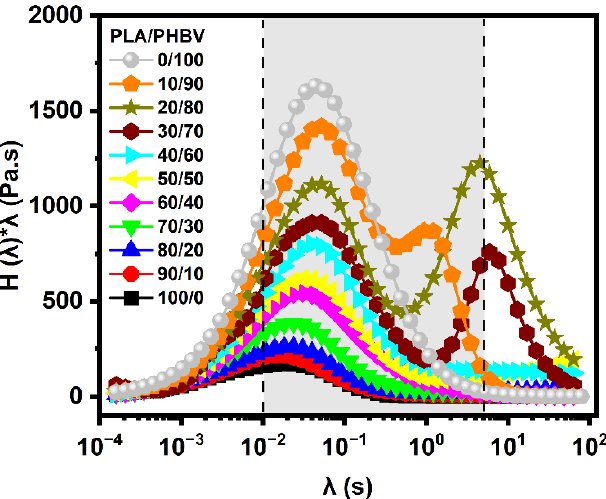
Figure 13. Weighted relaxation spectra for neat PLA, PHBV, and their blends at 175 °C. (Experimental values were located in the grey zone from 0.01 s to 5 s).